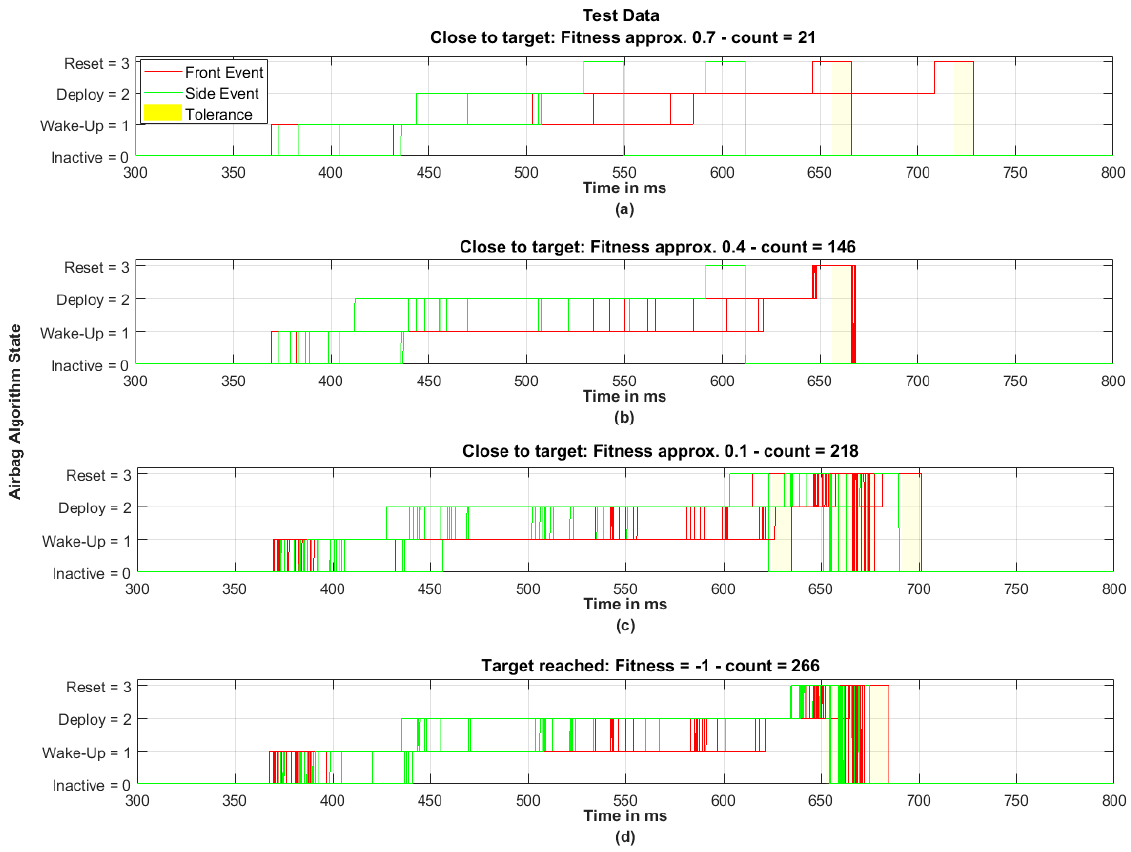
Figure 19. Case 2—Parallel event: test input data at different fitness values. ( a ) fitness value approx. 0.7; ( b ) fitness value approx. 0.4; ( c ) fitness value approx. 0.1; ( d ) fitness value equal − 1.